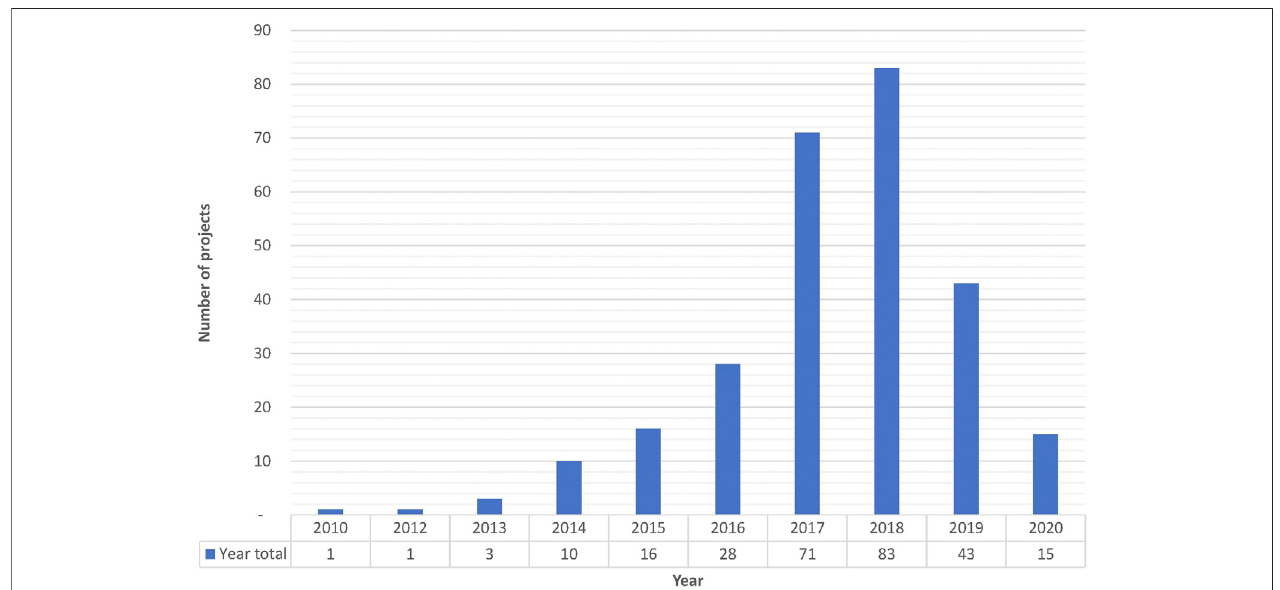
FIGURE 1 | The number of blockchain projects created in each